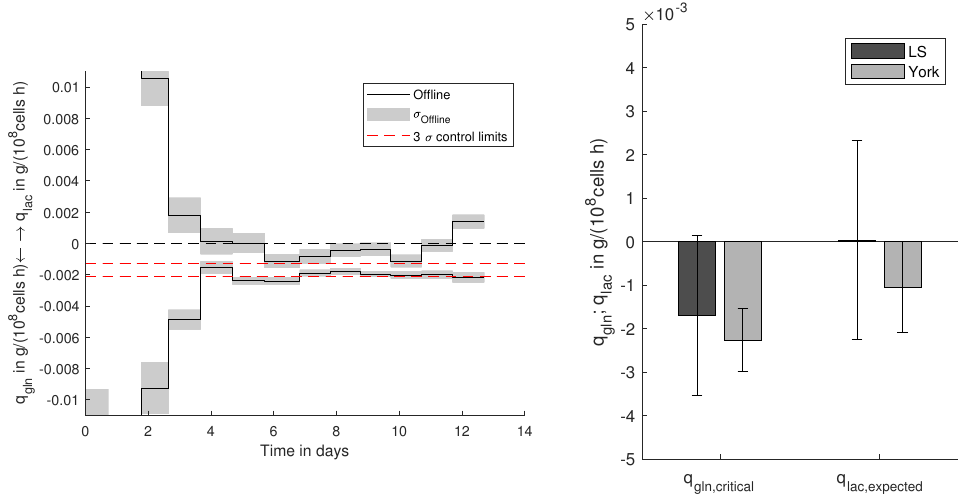
Figure 6. Control limits for cell-specific glutamine uptake ( q gln ) to avoid lactate ( q lac ) production with offline-determined specific rates with their standard deviation ( σ offline ) of the examined CHO cell process. Deduction of control limits based on York and LS regression with their expected lactate production with 99%